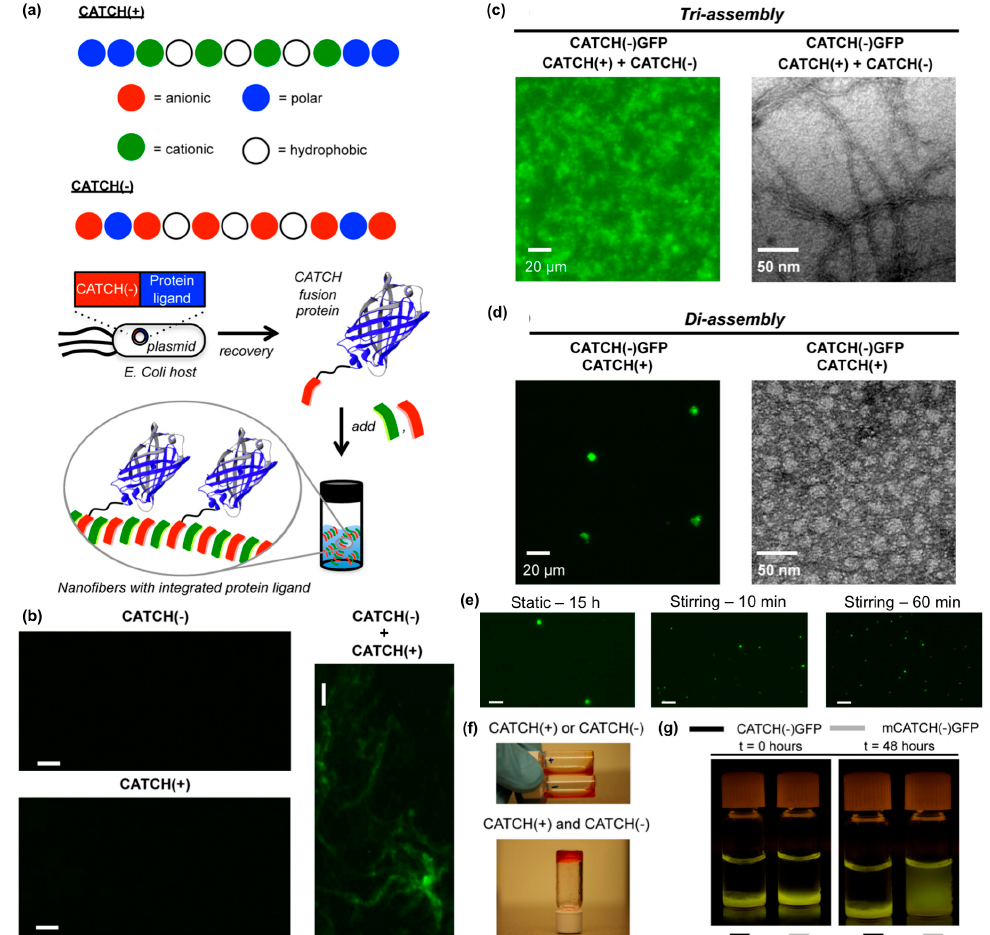
Figure 11. Co-assembling peptide tags for protein immobilization within nanofibrillar hydrogels. ( a ) Schematic representation of the Co-Assembly Tags based on CHarge complementarity (CATCH) nanofiber system. ( b ) Fluorescence photomicrographs of solutions containing Thioflavin T (ThT) and CATCH( − ) only, CATCH( + ) only, or an equimolar mixture of CATCH peptides.